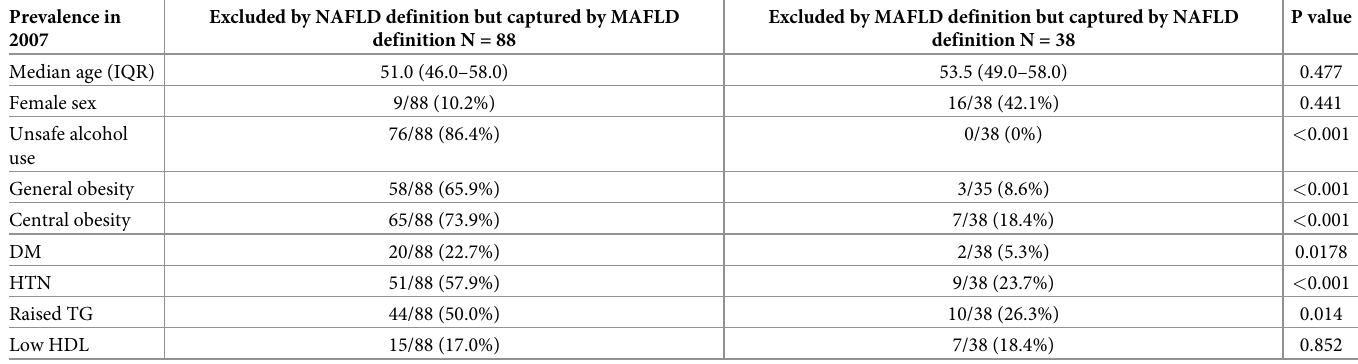
Table 3. Characteristics of those excluded by NAFLD and MAFLD definitions from the original cohort (2007). Prevalence in